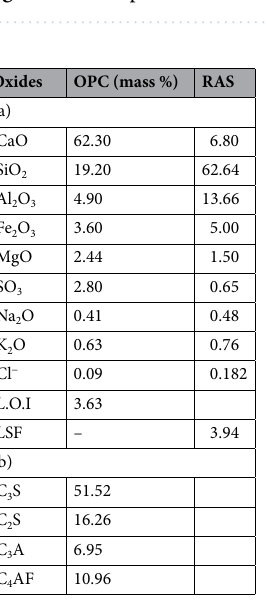
Figure 1. XRD pattern of RAS.